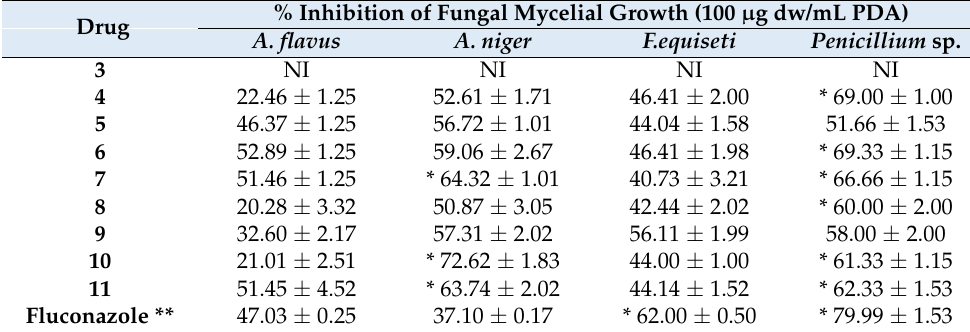
Table 4. Percentage of the zone of inhibition against fungal pathogens (in vitro) by the methyl α - L -rhamnopyranoside esters.